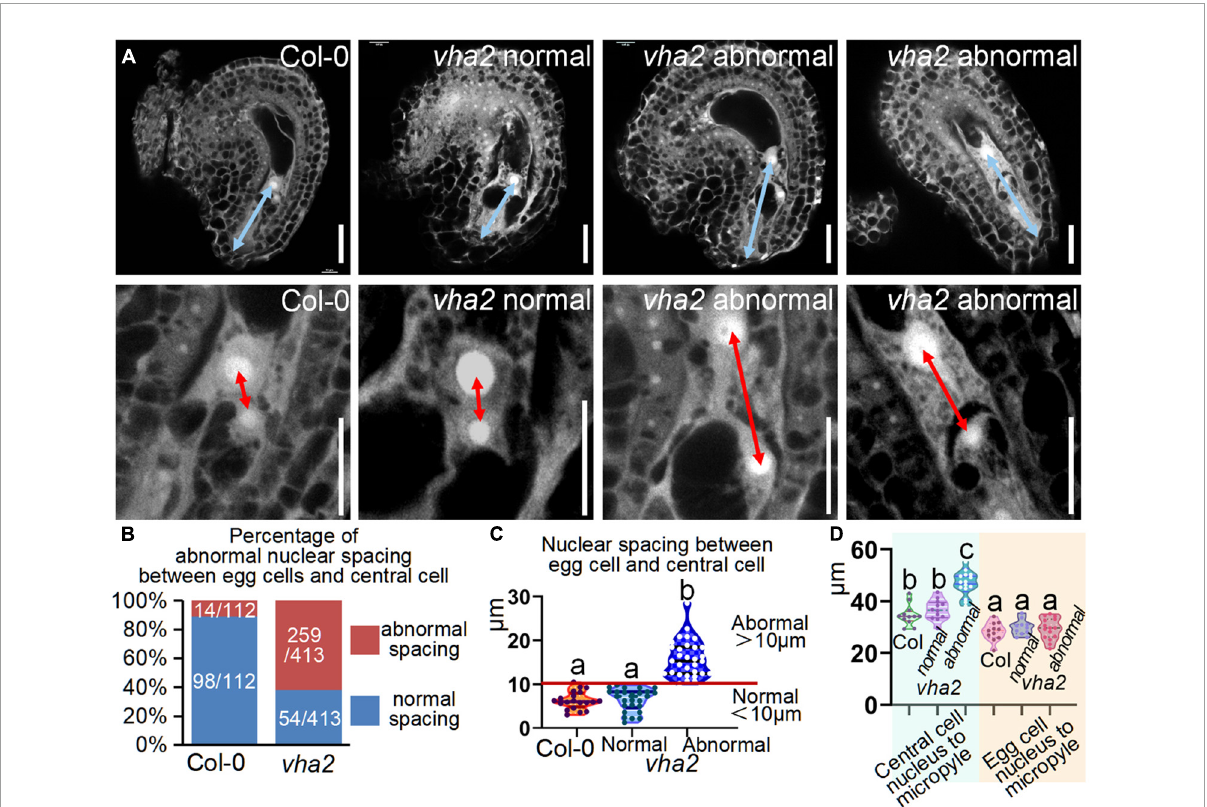
FIGURE4 Lack of V-ATPase enlarges nuclear spacing of egg cells and central cells. (A) Embryo sac development of Col-0 and vha2 at late-FG6 stage visualized by fluorescence microscopy. The picture below is an enlarged view of the nuclear spacing between the egg cell and central cell in the above image. The blue double arrows represent the distance from the central cell nucleus to the micropylar end, and the red double arrows in enlarged views represent nuclear spacing between egg cell and central cell. Bars = 20 µ m. (B) Statistics analysis of the proportion of abnormal nuclear spacing between egg cell and central cell in Col-0 and vha2. The number of ovules counted and the actual ratio is marked in the image. (C) Statistics analysis of nuclear spacing between egg cell and central cell in Col-0 and vha2 . Below the red line is defined as normal spacing if the nuclear spacing between egg cell and central cell is less than 10 µ m, and it was considered abnormal spacing if spacing exceeds 10 µ m. Lowercase letters indicate statistically significant differences between different stages ( P < 0.05). 100 ovules shown in the statistical graph come from 20 different inflorescence apices. (D) Statistics analysis of the distance from the central cell nucleus or egg cell nucleus to the micropylar end in Col and vha2. Lowercase letters indicate statistically significant differences between different stages ( P < 0.05). 30 ovules shown in the statistical graph come from 3 different inflorescence